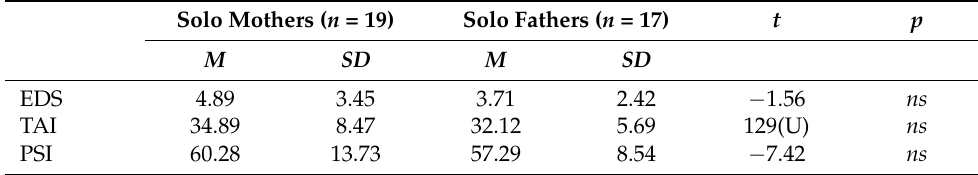
Table 6. Means, SDs, t and p values comparisons between mothers’ and fathers’ scores on the Edinburgh Depression Scale, the Trait Anxiety Scale and the Parenting Stress Inventory. Solo Mothers ( n =